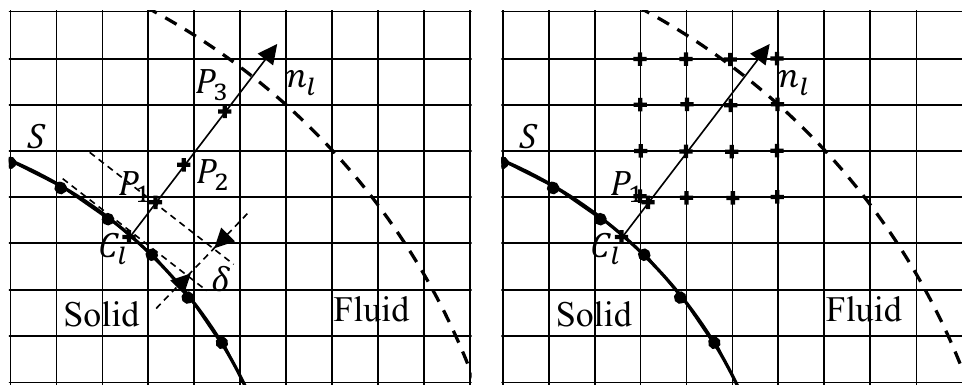
Figure 2. Notations for the third order Lagrange extrapolation ( left ) and the third order Taylor interpolation ( right ), used in heat flux computations.